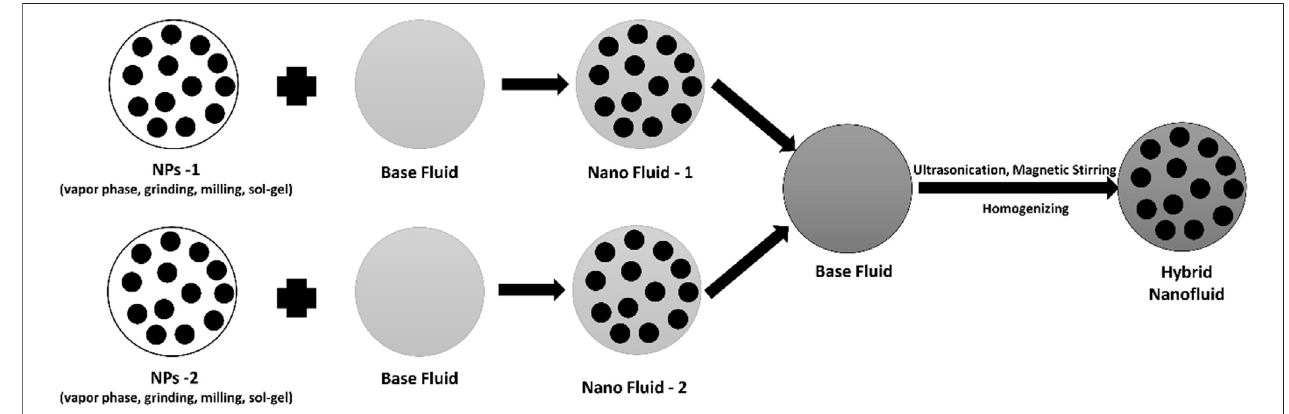
FIGURE 1 | Schematic illustration of two step synthetic